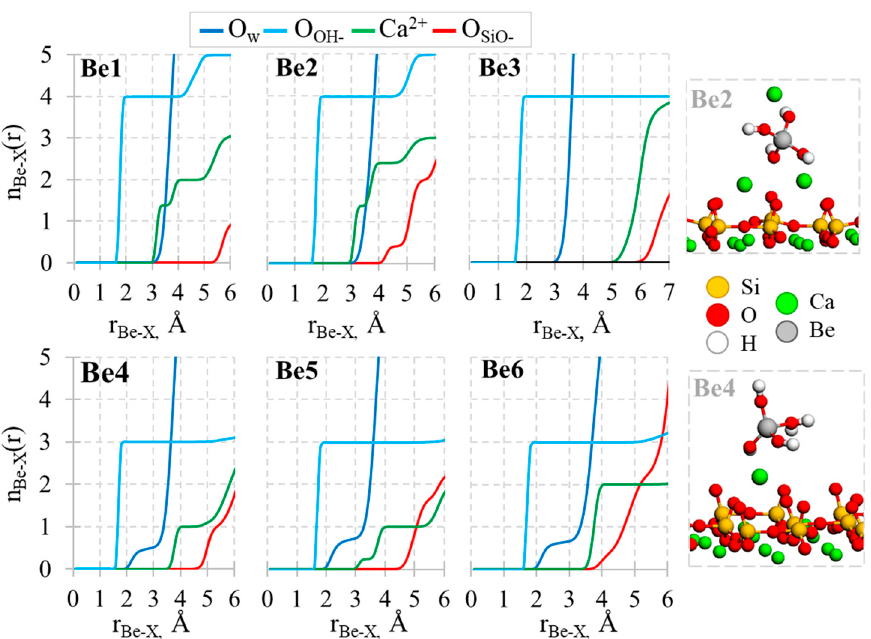
Figure 4. Running coordination numbers for Be-X atom pairs for selected Be atoms. Snapshots of the corresponding Be2 and Be4 surface complexes (water molecules omitted for clarity). O w and O OH- correspond to the oxygen atoms in water and hydroxyl-groups, respectively.